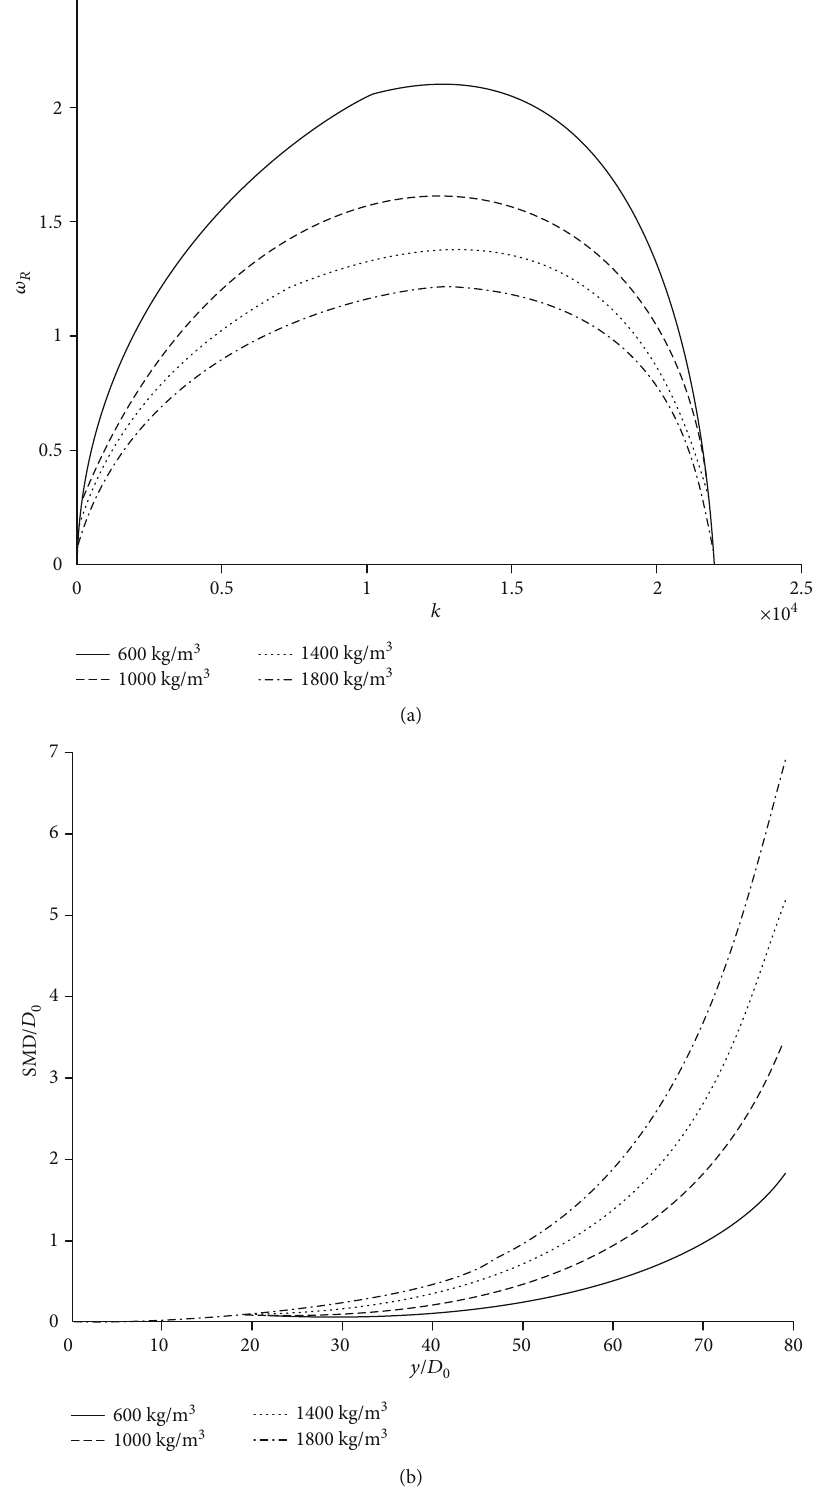
Figure 5: E ff ect of liquid density to (a) surface wave growth rate and (b) droplet size distribution ( σ = 0 : 0728 N/m 2 , ρ 13 : 39m/s , and q = 96 : 35